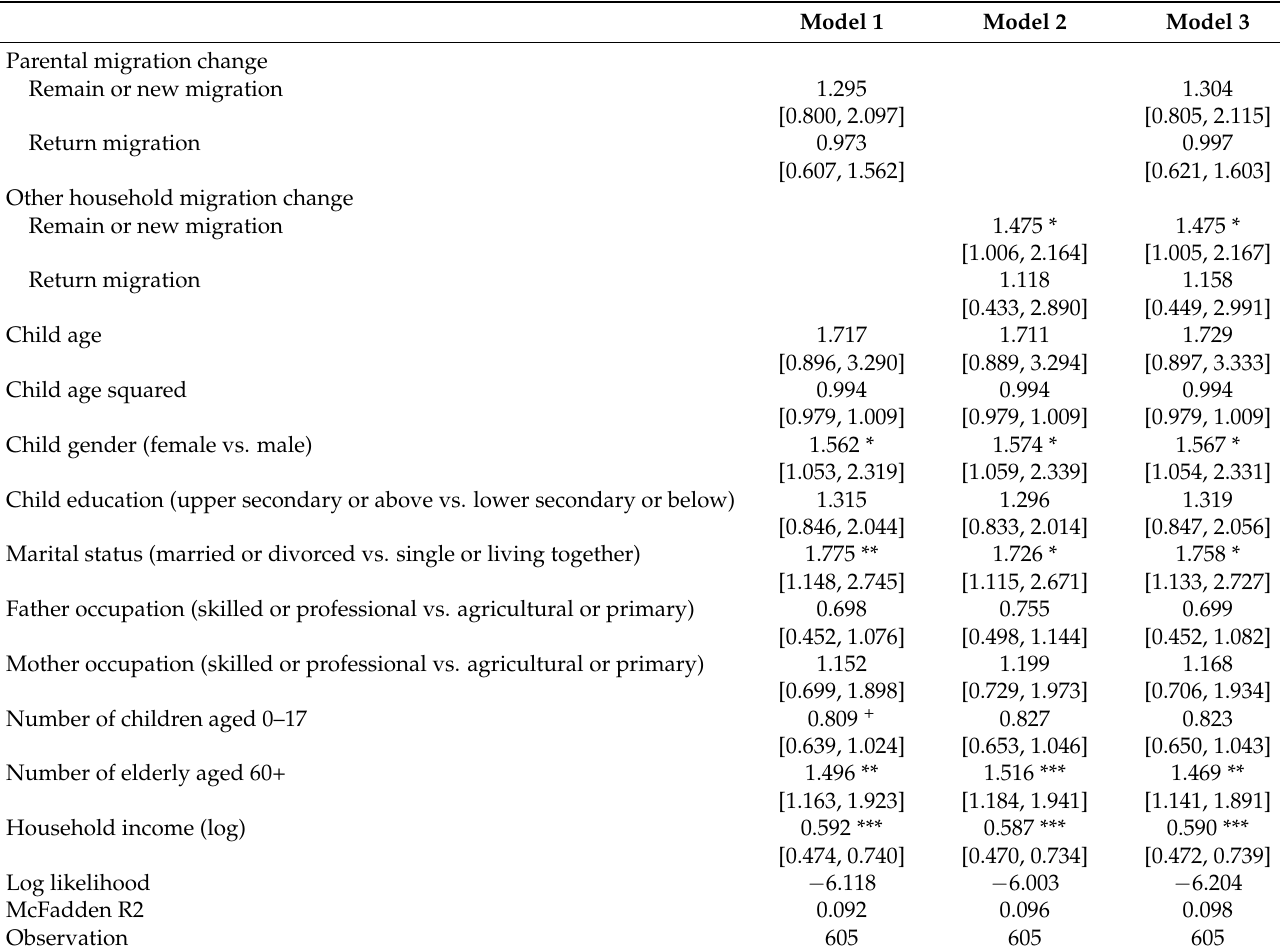
Table 5. Effects of relay migration on youth labor